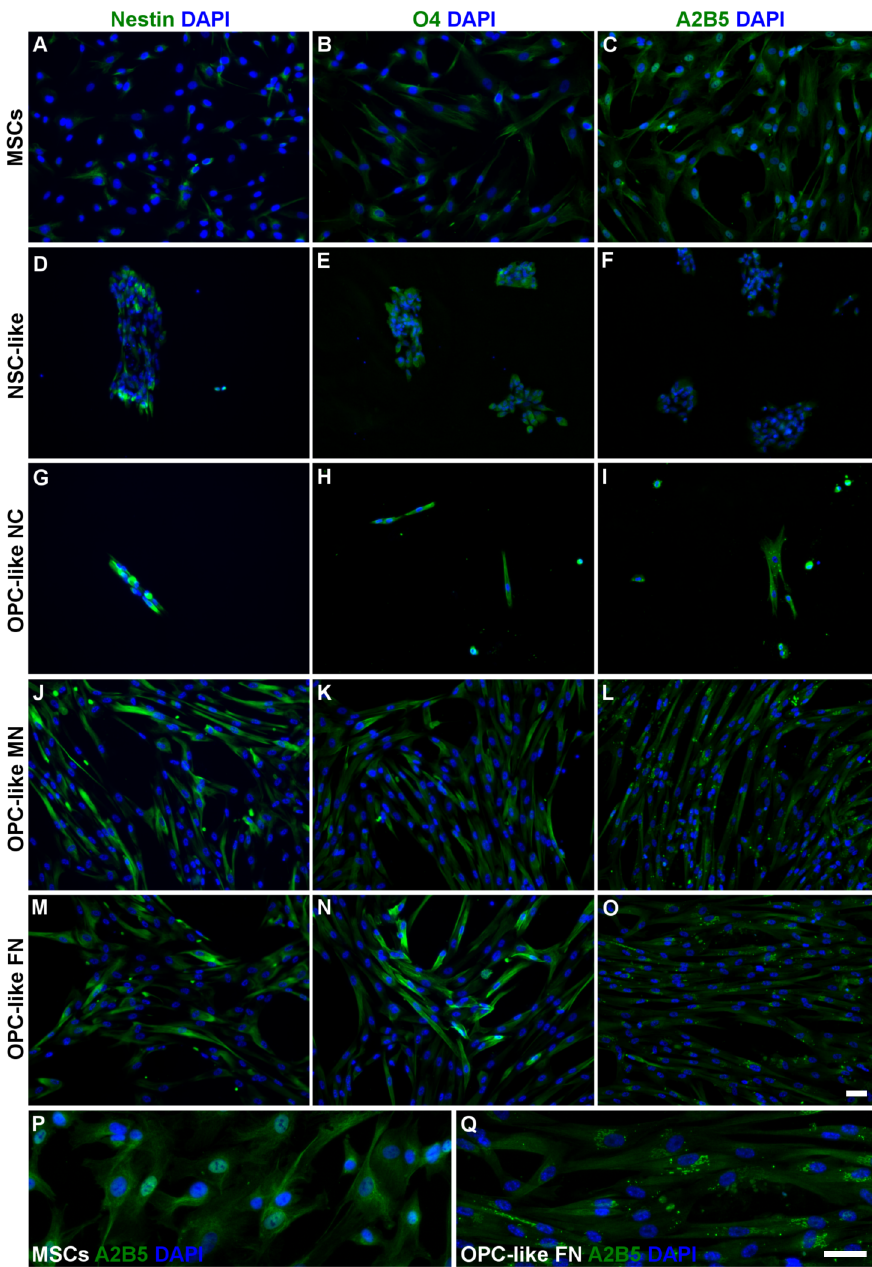
Figure 4. Expression of neural- and oligodendroglial-precursor markers in hUCM-MSCs, NSC- and OPC-like cells. The expression of nestin (neural precursor marker), A2B5 (OPC marker) and O4 (OPC/OL marker) in undifferentiated hUCM-MSCs ( A-C ), after neural-like induction ( D-F ) and OPC-like induction using non-coated ( G-I ), laminin-2 (merosin-MN)-coated ( J-L ) and fibronectin (FN)-coated ( M-O ) tissue culture polystyrene was determined by immunofluorescence microscopy (in green). ( P ) and ( Q ) are inserts of ( C ) and ( O ) images, respectively, to highlight the presence of the typical OPC punctate and perinuclear distribution of A2B5 in OPC-like cells ( Q ), in contrast with control hUCM-MSCs ( P ). Counterstaining of nuclei was performed with DAPI (in blue) and the scale bars represent 50 m m. Images are representative of at least 3 independent experiments. By the end of the OPC-like induction stage, the cells cultured on FN- or MN-coated plates survived well and maintained the spindle shape morphology, when compared with cells cultured on uncoated wells, which did not attach well to the surface and only some small adherent clusters and single cells survived until the end of this stage (Figure 4G-O).